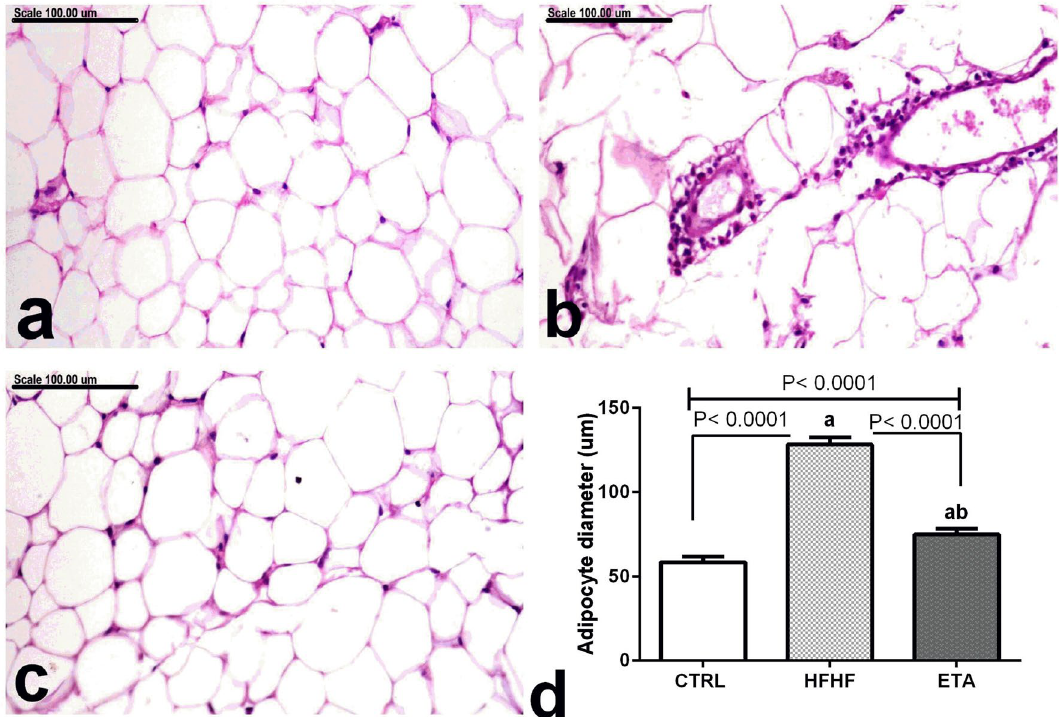
Figure 8. ETA diminished HFHF-induced changes in adipocyte size. The photomicrographs show abdominal adipose tissue of the following groups: ( a ) control rats showing normal unilocular white adipocytes, ( b ) HFHF model showing necrotic adipocytes surrounded by macrophages, ( c ) ETA-treated rats showing marked reduction of adipocytes size, ( d ) Mean of the adipocyte diameter measured in all groups. Data are the mean ± SD and are representative of a single independent experiment ( n = 6). Statistical analysis was performed using one- way ANOVA, followed by Tukey’s multiple comparison tests. a Significantly different from the control group. b Significantly different from the HFHF group. Differences were considered statistically significant if p <